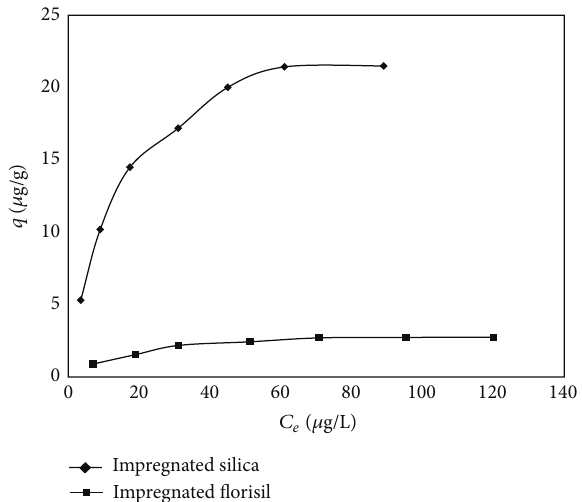
Figure11:LangmuirisothermforAs(V)adsorptiononimpregnated silica and florisil.